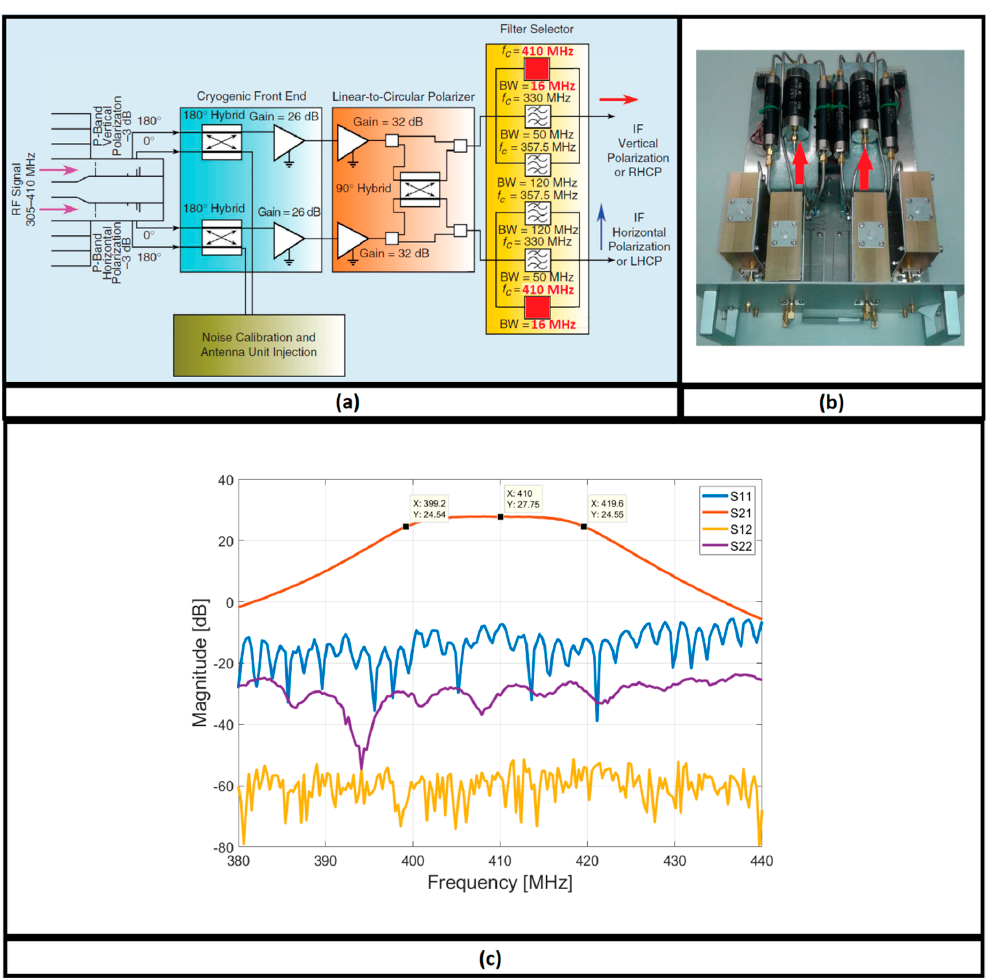
Figure 3. ( a ) Schematic of the P-band receiver with the space debris Band Pass Filters (BPFs) highlighted in red; ( b ) a photo of the 20 MHz bandwidth BPFs at 410 MHz (indicated by red arrows) mounted inside the filter selector block; ( c ) S-parameter of the P-band receiver cryogenic block measured in a laboratory test using a vector network analyzer.